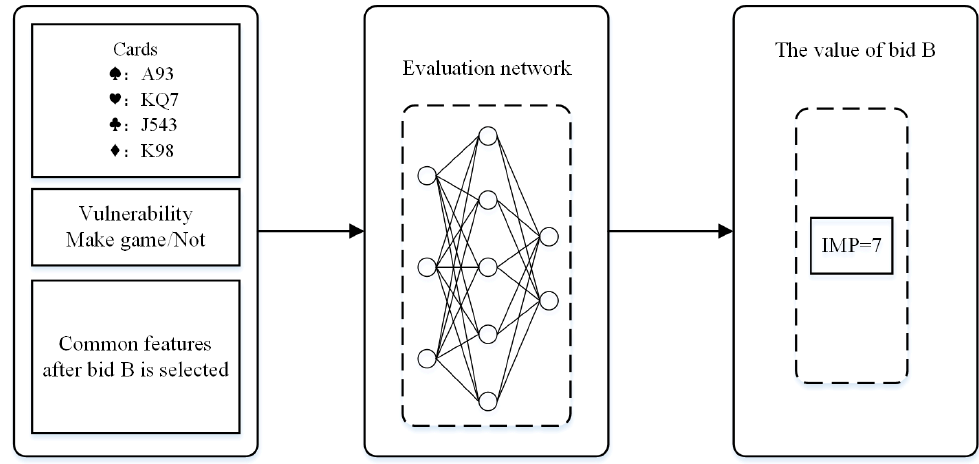
Figure 5. Schematic representation of the evaluation model.